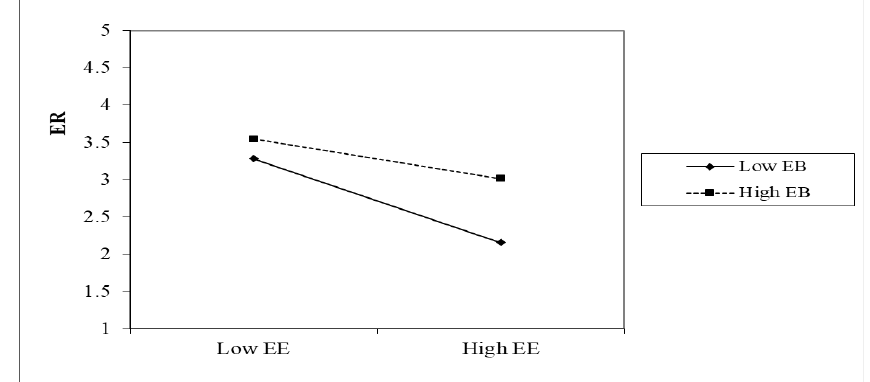
Figure 2. Path diagram